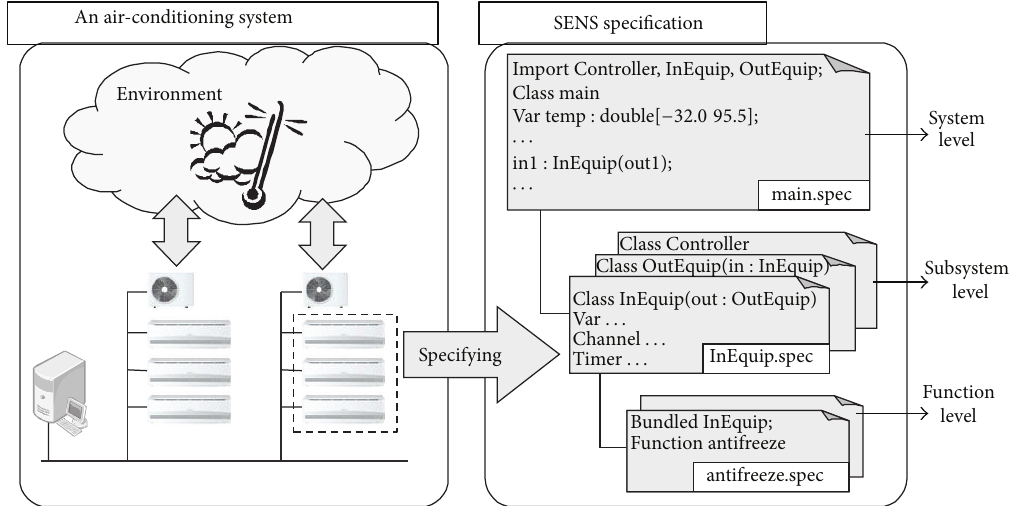
Figure 1: An air-conditioning system and its SENS specification.